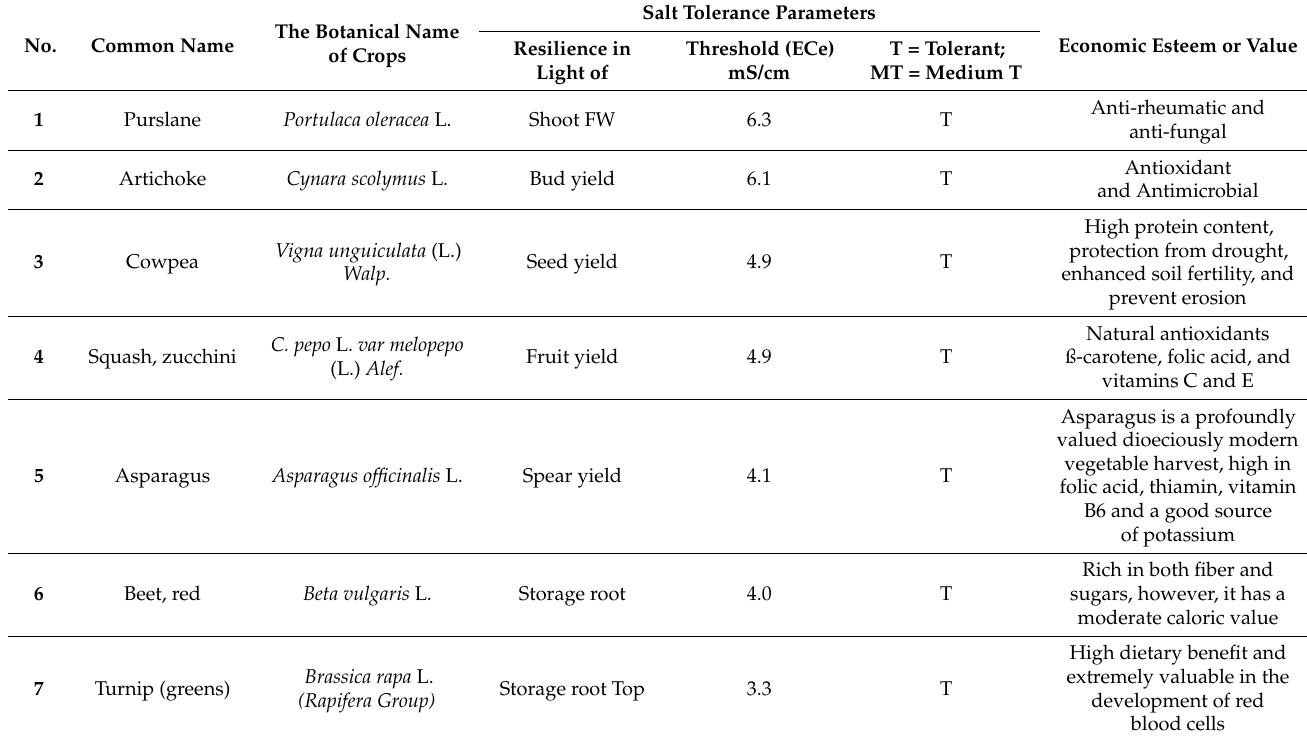
Table 2. Salt resilience vegetables and fruit crops.